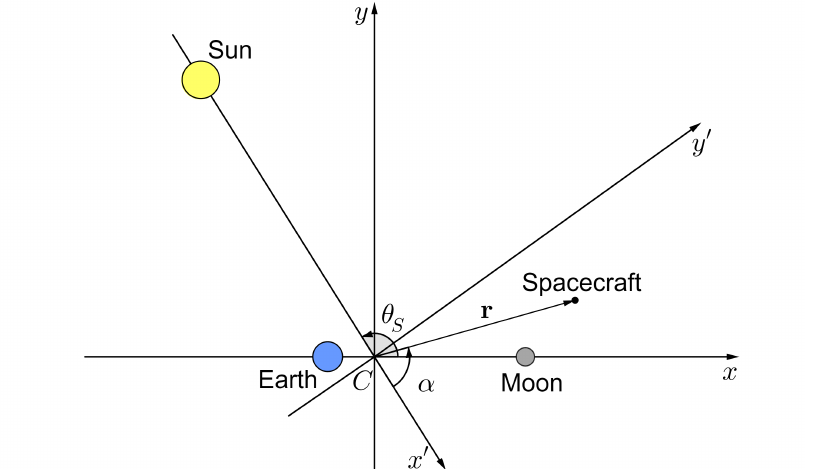
Figure 5. Earth–Moon and Sun–barycenter rotating reference frames Cxy and Cx (cid:48) y (cid:48) . The radius vector of the spacecraft in the Sun–barycenter frame is described by the polar angle α